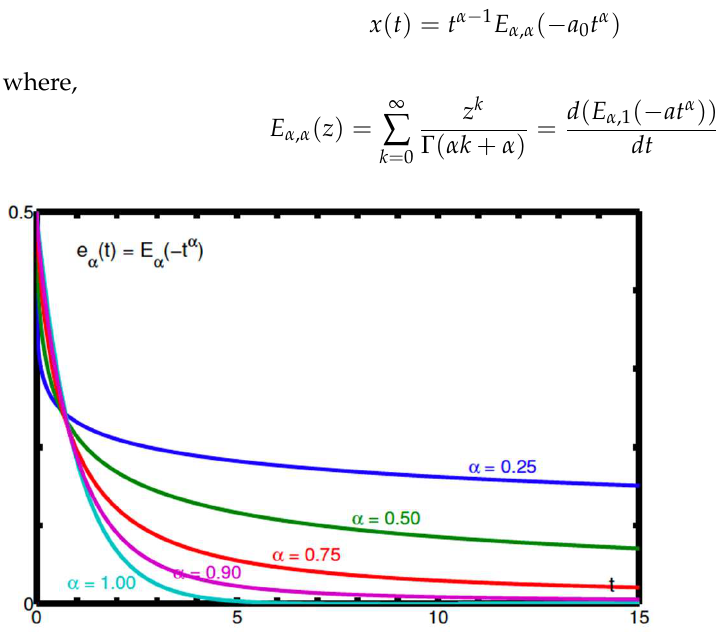
Figure A1. Homogeneous Solution of Equation (A2) for various values of α .